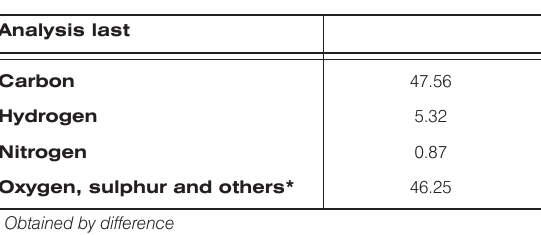
Table1. Properties of bamboo used in this